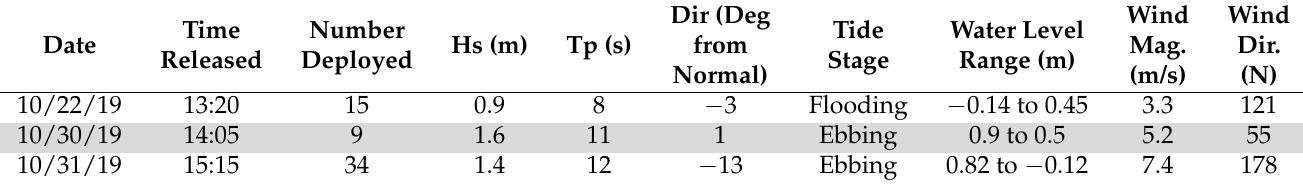
Table 1. Environmental conditions for the three drifter deployments and image